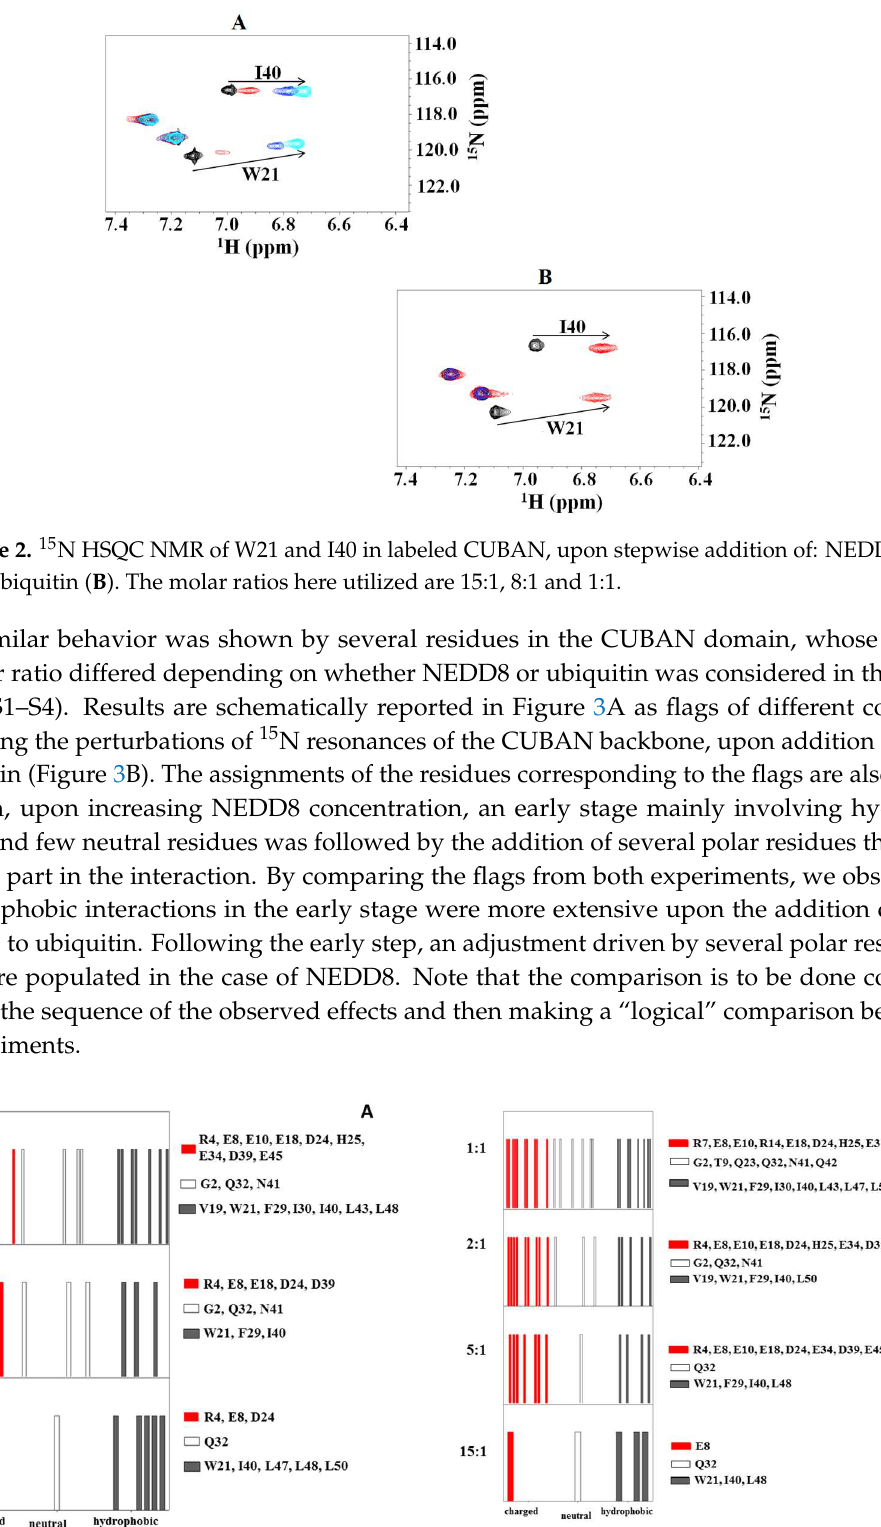
Figure 3. ( A ) Flags representing the residues of CUBAN domain that were perturbed in the 15 N HSQC NMR by the interaction with NEDD8. Molar ratios from 15:1 to the final 1:1 were monitored. ( B ) Flags representing the residues of CUBAN domain perturbed in the 15 N HSQC NMR by the interaction with Ubiquitin. Molar ratios from 15:1 to the final 1:1 were monitored. Flag colors indicate perturbed residues with polar (red), neutral (empty) and hydrophobic (black) side chains.